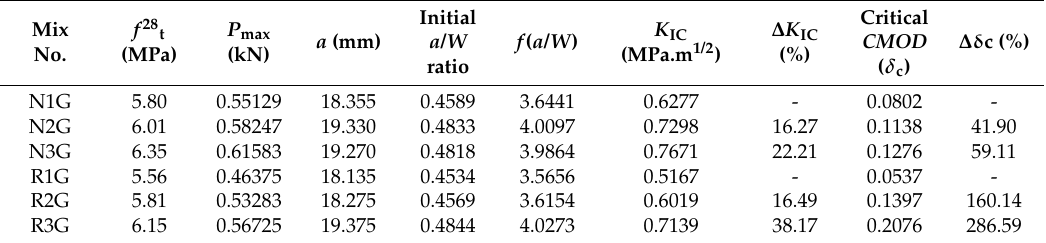
Table 7. Fracture toughness properties of six groups of GONM and GORM specimens.